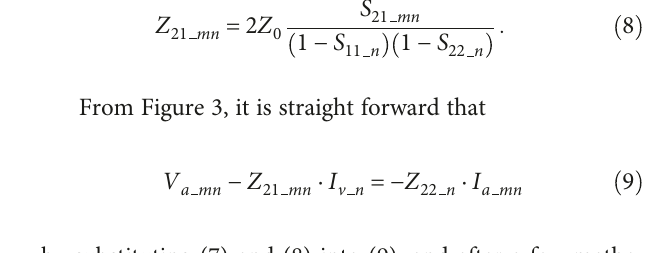
Figure 6: Magnitude of radiation patterns that transmit the same symbol at 60 ° for two di ff erent values of PE vector